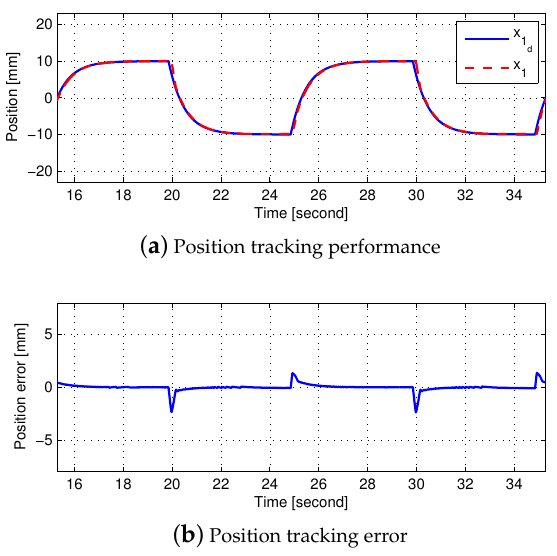
Figure 8. Position tracking performance of the proposed method in